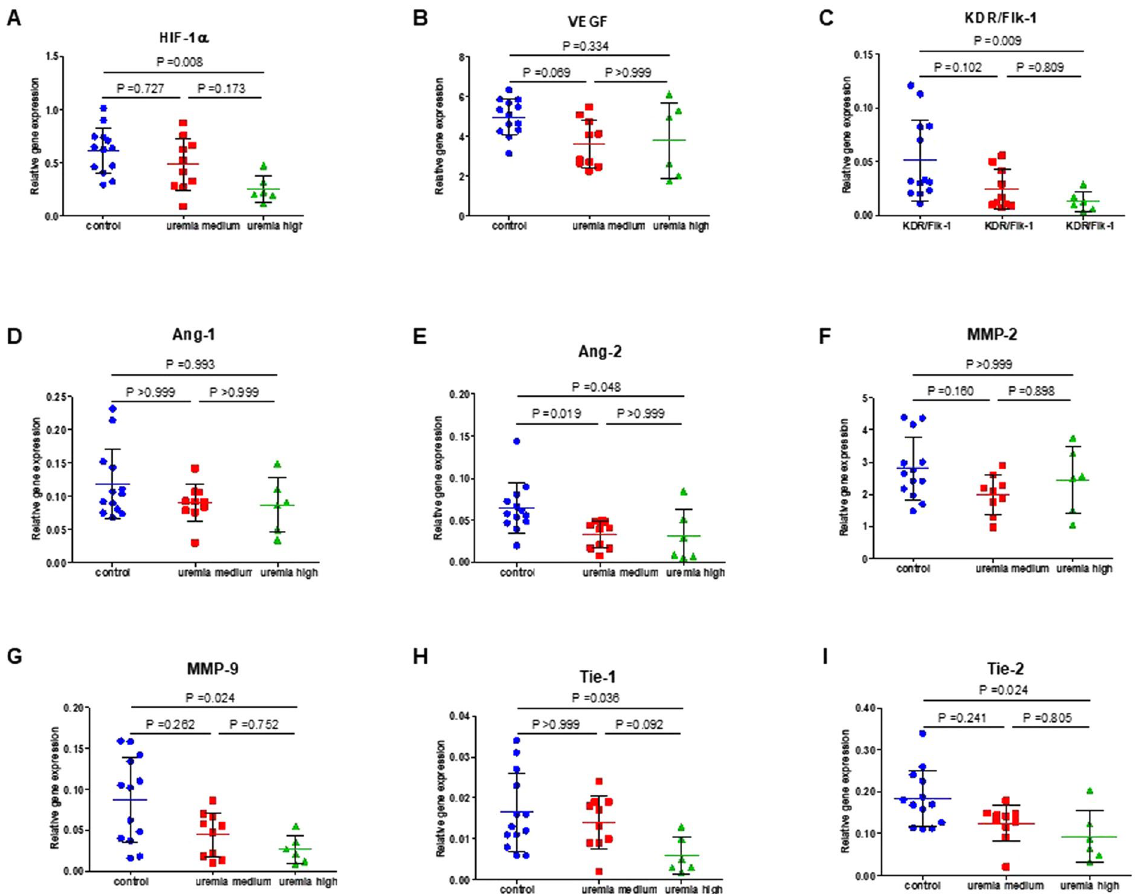
Figure 5. Microvessel density of uremic mice in the myocardium declines in parallel with the density in the cremaster muscle. Myocardial tissue sections were stained with an monoclonal antibody against mouse CD31 and microvascular density was expressed as percentage of positively stained area. ( A ) Microvessel density (mean + SD) in the myocardium of controls (n = 8), mildly (n = 3; * p = 0.012); and severely uremic mice (n = 6; ** Mann Whitney test: p = 0.0007). ( B ) Significant inverse linear correlation of microvascular density in myocardium with urea (r = − 0.73; p < 0.0022). ( C ) Close correlation of microvascular density (CD31 staining) in myocardium with microvascular density in the cremaster muscle measured by intravital imaging (r = 0.90; p < 0.0001) in identical animals. Dotted lines in ( B ) and ( C ) indicate confidence